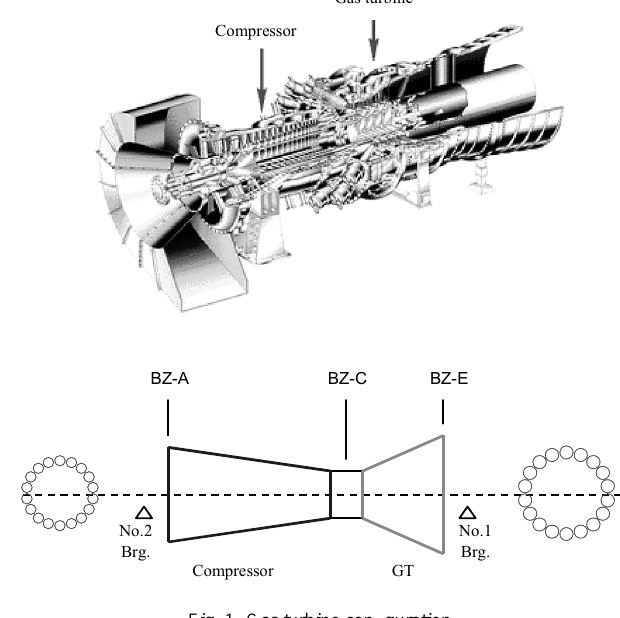
Fig. 1. Gas turbine